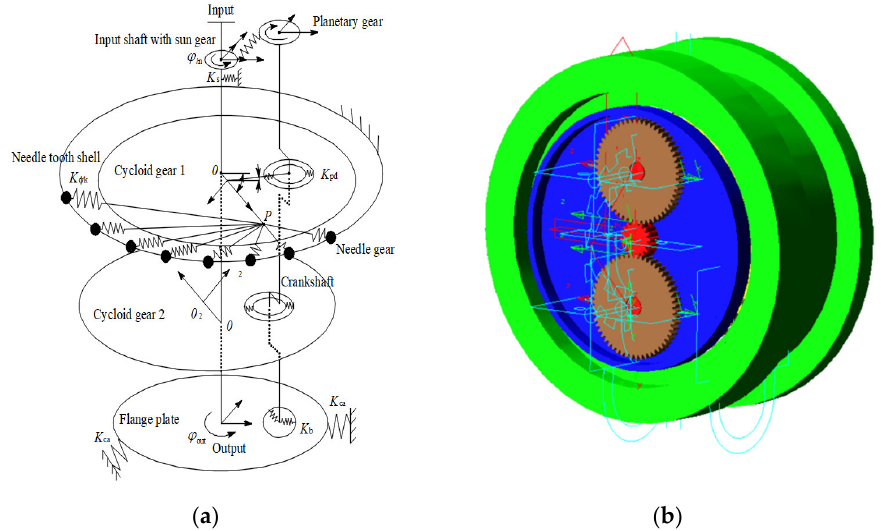
Figure 7. Two model diagrams of RV-40E Reducer. ( a ) Equivalent spring error model of RV-40E reducer. ( b ) Virtual prototype of RV-40E reducer. reducer. ( b ) Virtual prototype of RV-40E